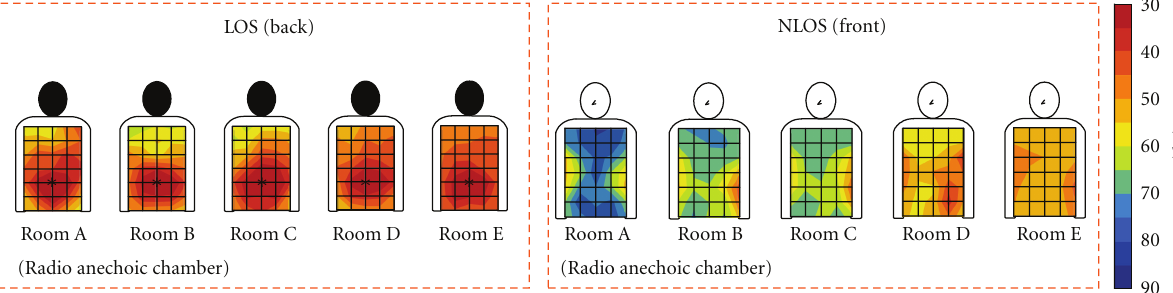
Figure 13: Spatial distribution of UWB propagation losses in the five rooms. The transmitting antenna was placed at point denoted by “ ∗ ”.